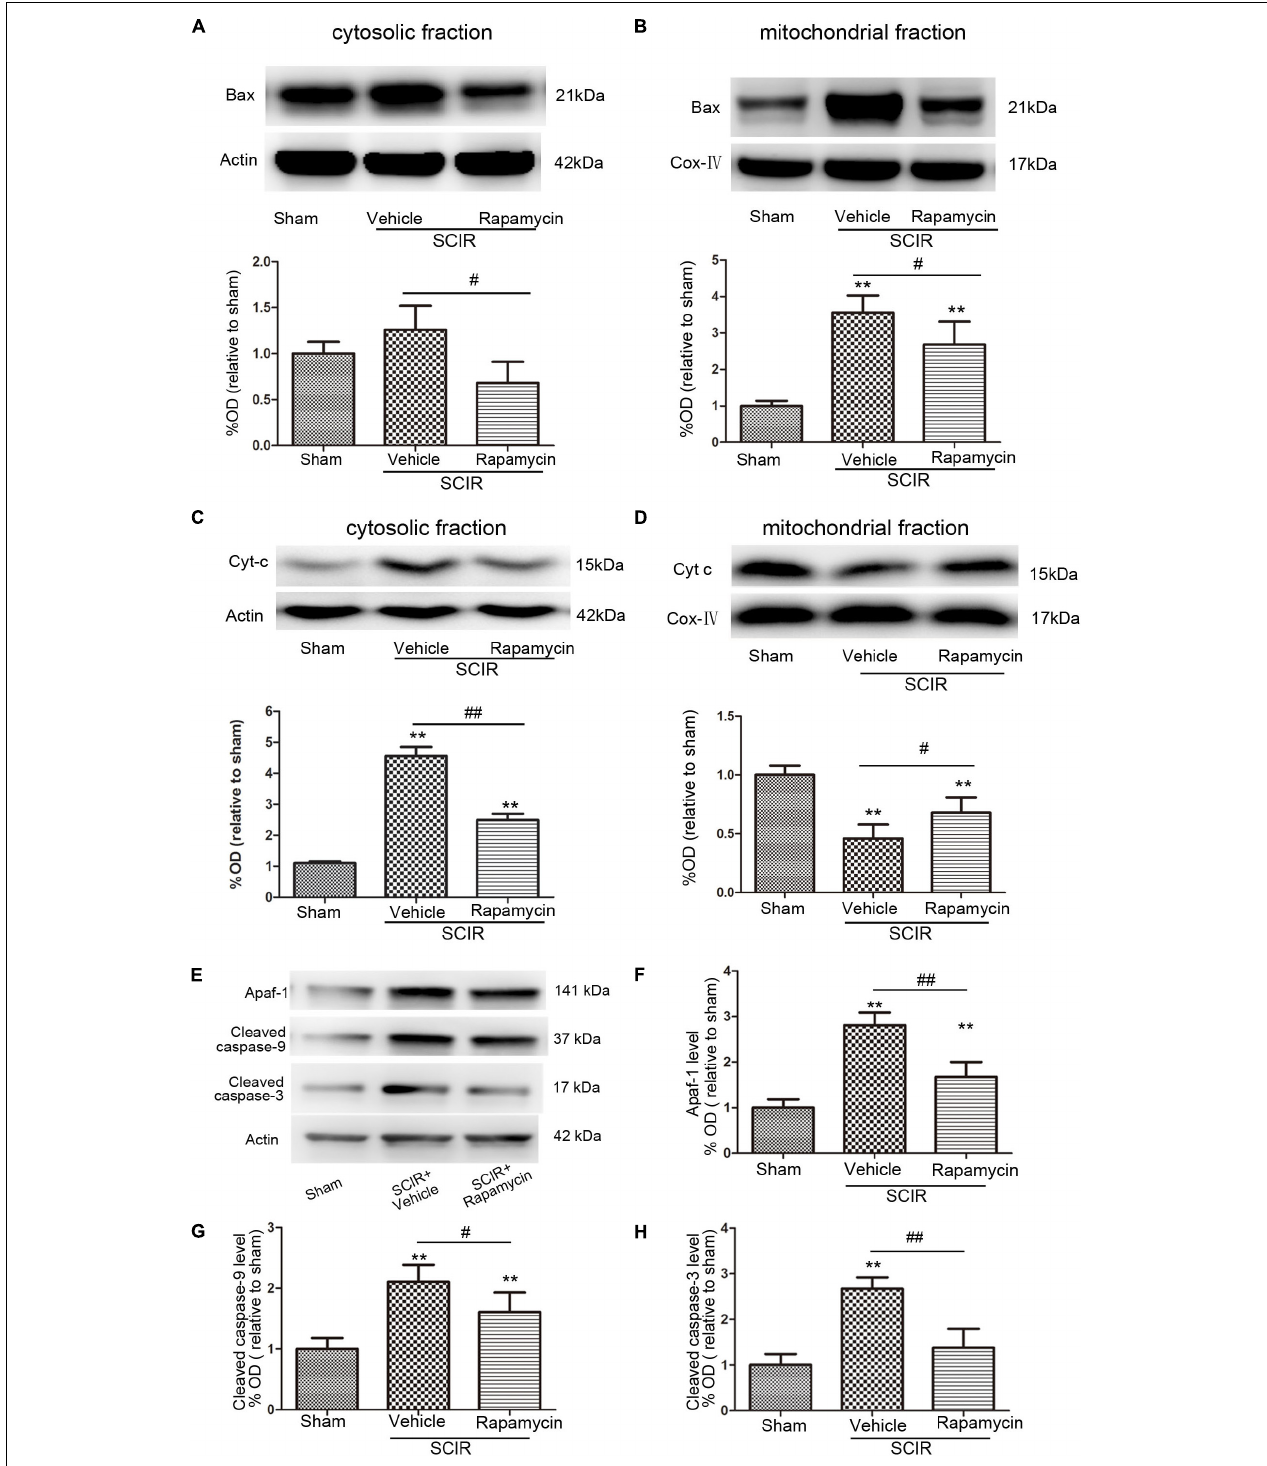
FIGURE 3 | Rapamycin treatment following spinal cord ischemic injury reduced mitochondrial release of apoptosis related proteins. (A,B) Representative western blots and quantitative graphs demonstrate the expression of Bax in cytosolic and mitochondrial fractions at 24 h after SCIRI. Data are presented as the mean ± SD, n = 6. ∗ p < 0.05, ∗∗ p < 0.01 vs. Sham; # p < 0.05, ## p < 0.01. (C,D) Representative western blots and quantitative graphs demonstrate the expression of Cyt-c in cytosolic and mitochondrial fractions at 24 h after SCIRI. Data are presented as the mean ± SD, n = 6. ∗ p < 0.05, ∗∗ p < 0.01 vs. Sham; # p < 0.05, ## p < 0.01. (E–H) Representative western blots and quantitative graphs demonstrate the expression of mitochondrial apoptosis related proteins (Apaf-1, cleaved Caspase-3, cleaved Caspase-9) at 24 h after SCIR. Data are presented as the mean ± SD, n = 6. ∗ p < 0.05, ∗∗ p < 0.01 vs. Sham; # p < 0.05, ## p < 0.01.